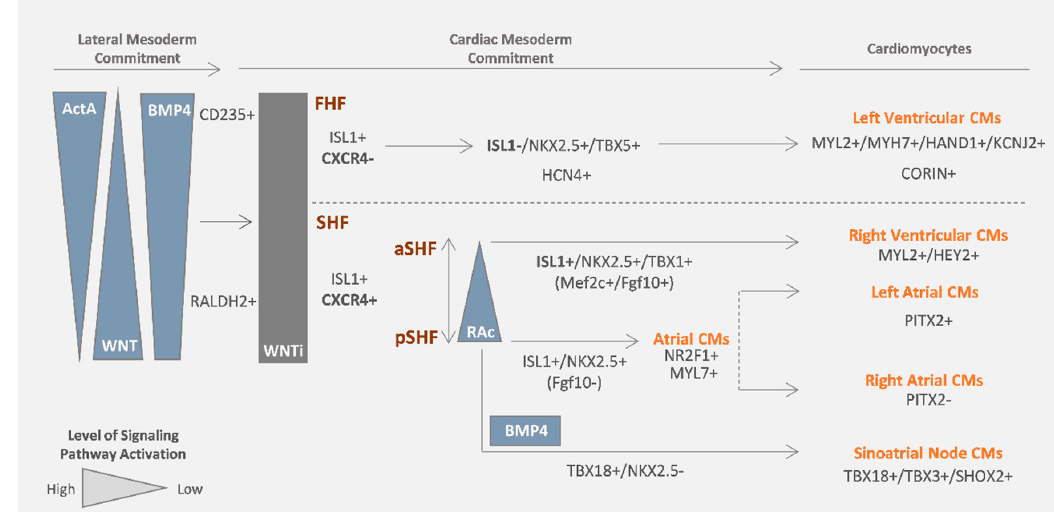
Figure 2. In vitro modulation of human pluripotent stem cell (hPSC) differentiation towards the different subtypes of cardiomyocytes (CMs). FHF, first heart field; SHF, second heart field; ActA, Activin A signaling; WNT, Wnt signaling; WNTi, Wnt signaling inhibition; RAc, retinoic acid signaling; aSHF, anterior SFH; pSHF, posterior SHF. Information collected from in vitro hPSC cardiac differentiation studies ([27,29,32–34]). The markers that are in lowercase were taken from mouse model studies.